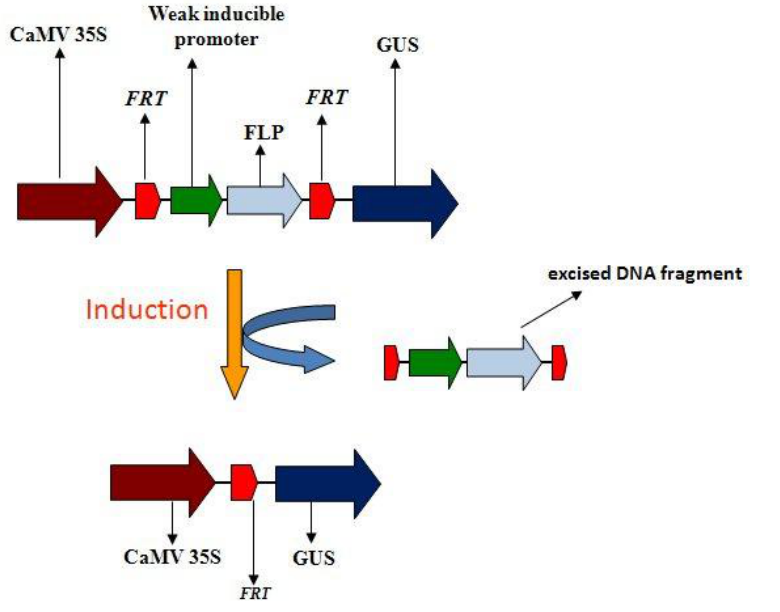
Figure 1. Schematic representation of the FLP/ FRT site-specific recombination system in phytosensing. Upon induction, the FLP recombinase protein produced will recognize the FRT sites and the region between these two FRT recognition sites will be excised and the reporter gene GUS is brought under the influence of the CaMV 35S promoter resulting in plant-wide expression of GUS. FLP—flipping DNA recombinase, FRT—FLP recombination target; GUS— 